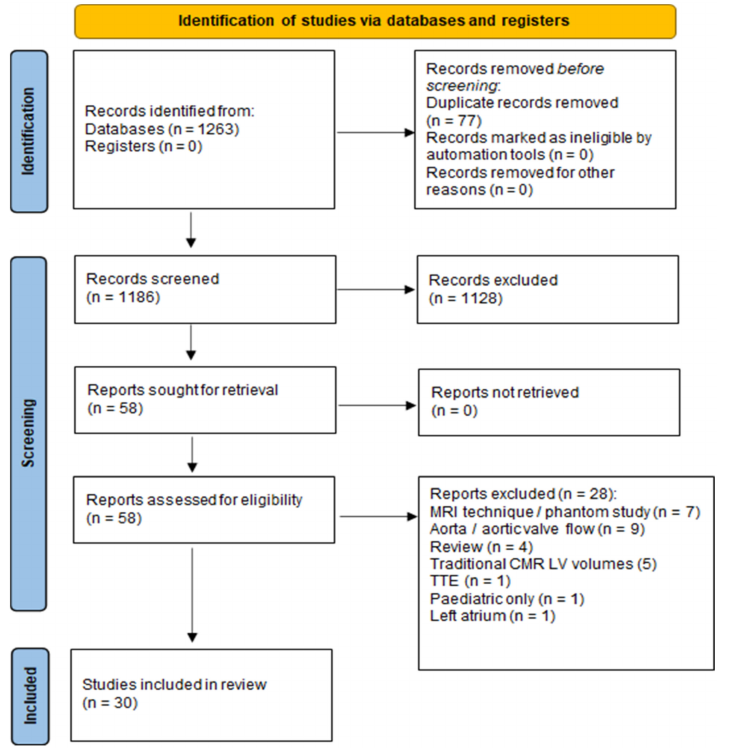
Figure 1. PRISMA flow diagram showing studies inclusion process